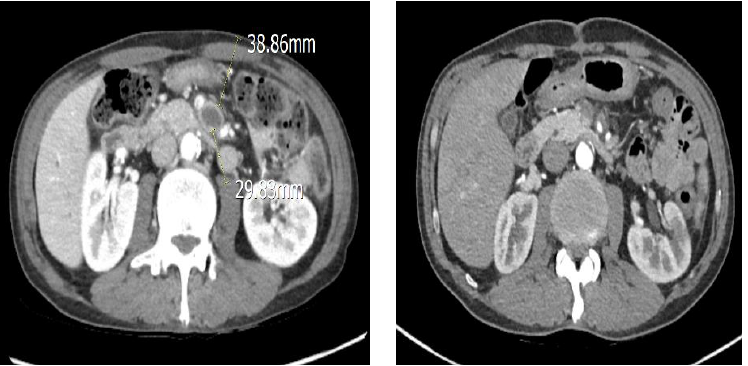
Figure 4. CT showing SMA mycotic aneurysm. The first picture is pre-operative, while the second is post-operative.